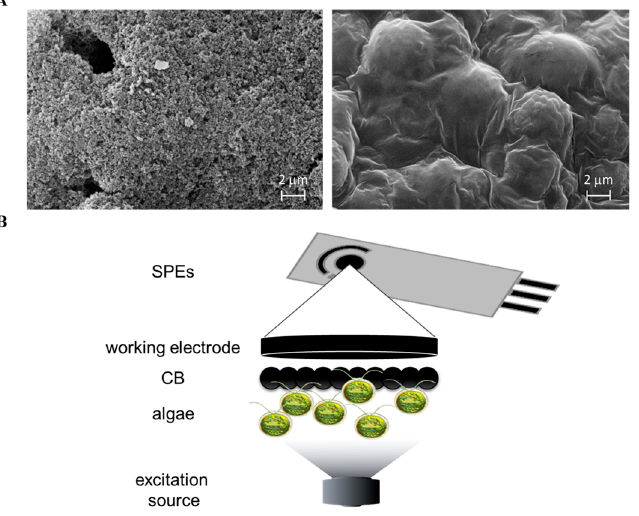
Figure 4. ( A ) SEM microphotographs of CB modified SPEs (left) and CB modified SPEs functional- ized with algae whole cells entrapped into the calcium/alginate matrix (right). ( B ) Scheme of the obtained cytosensor for pathogen detection in wastewater. ( B ) Scheme of the proposed algal/CB- SPE cytosensor.